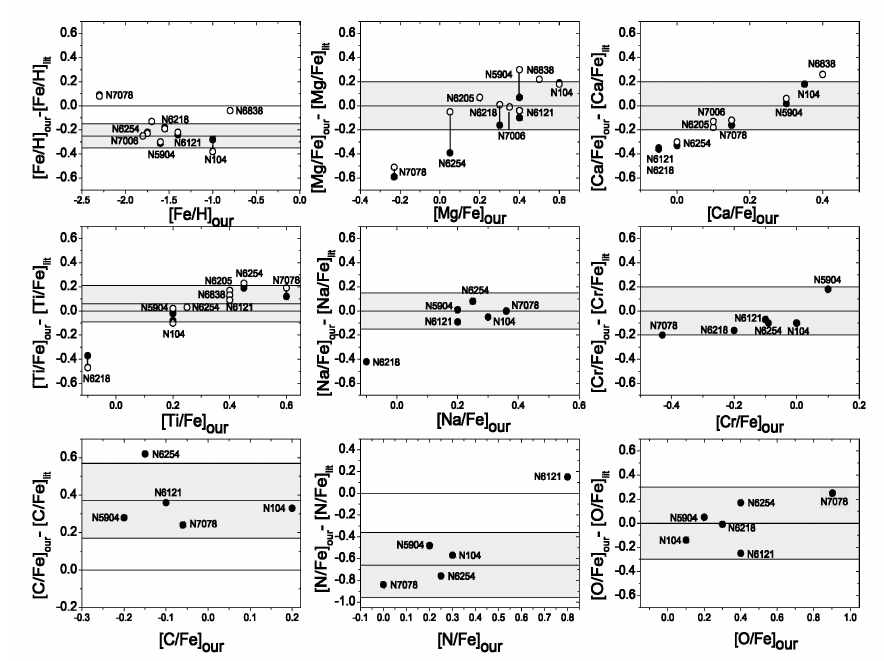
Fig. 3. Comparison of our element abundances to those from Pritzl et al. (2005) (open circles) and Roediger et al. (2014)